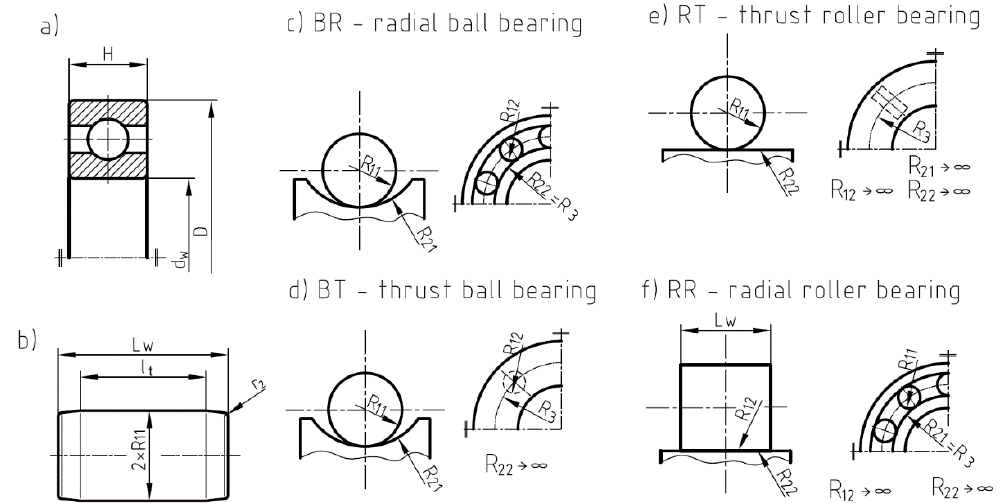
Figure 10. Dimensions of rolling elements and definitions of principal radii of curvatures in rolling bearings: ( a ) principal dimensions of rolling bearing, ( b ) dimensions of rollers, ( c ) principal radii of curvatures in radial ball bearing (BR), ( d ) principal radii of curvatures in thrust ball bearing (BT), ( e ) principal radii of curvatures in thrust roller bearing (RT), ( f ) principal radii of curvatures in radial roller bearing (RR).